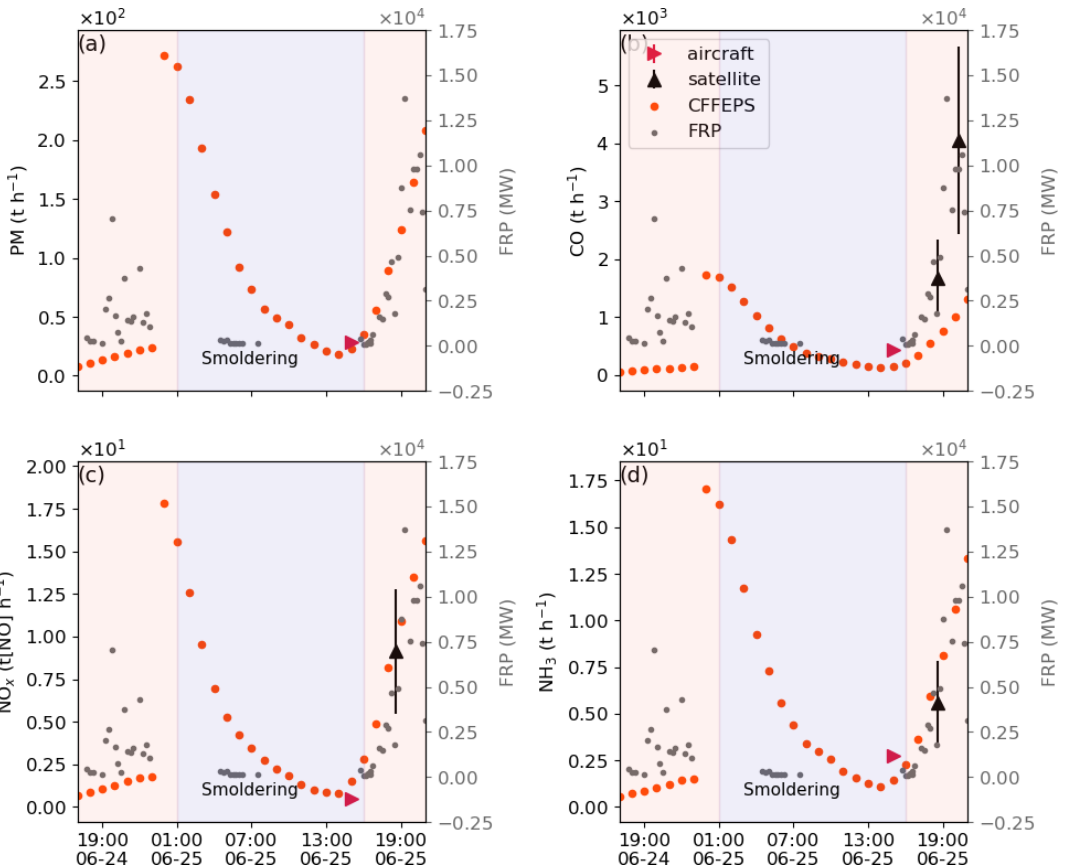
Figure 10. Fire radiative power (FRP; in MW) from GOES-R (grey dots) and emissions from the CFFEPS model (orange dots) from 24 June 2018 17:00UTC to 25 June 2018 21:00UTC. Local time = UTC − 6h. Aircraft-derived emission rates are shown for (a) PM 1 , (b) CO, (c) NO x (as NO), and (d) NH 3 (in th − 1 ; red arrow) at 15:00UTC when the aircraft flew closest to the fire. The corresponding TROPOMI satellite-derived emission rates are also shown (in th − 1 ; black arrows). Note that the aircraft flight time occurred when the fire intensity reflected a surface, smoldering fire and the satellite overpass time took place when the fire had transitioned to a crown (flaming) fire. The smoldering and flaming time periods are coloured in blue and pink,